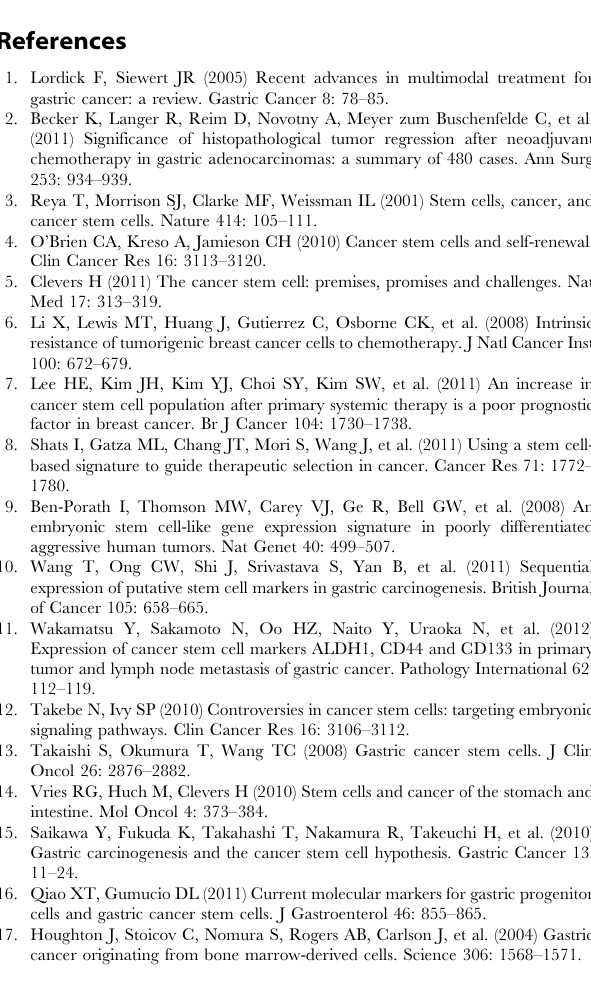
Table S1 Multivariate Cox regression analysis. Gene expression of GSK3B, CTNNB1, DNMT1 and the standard prognostic variables in GC, ypT, ypN, ypM and resection category were included in the model. Table S2 Gene expression data of the pre- and corresponding post-therapeutic tumour samples of patients with TRG2. Table S3 Gene expression data of the pre- and corresponding post-therapeutic tumour samples of patients with TRG3. Table S4 Multivariate Cox regression data for the own dataset.